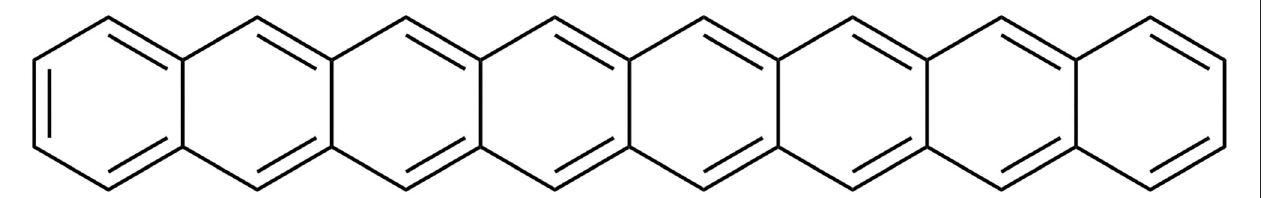
FIGURE 1 | Structure of 8-acene, containing eight linearly fused benzene